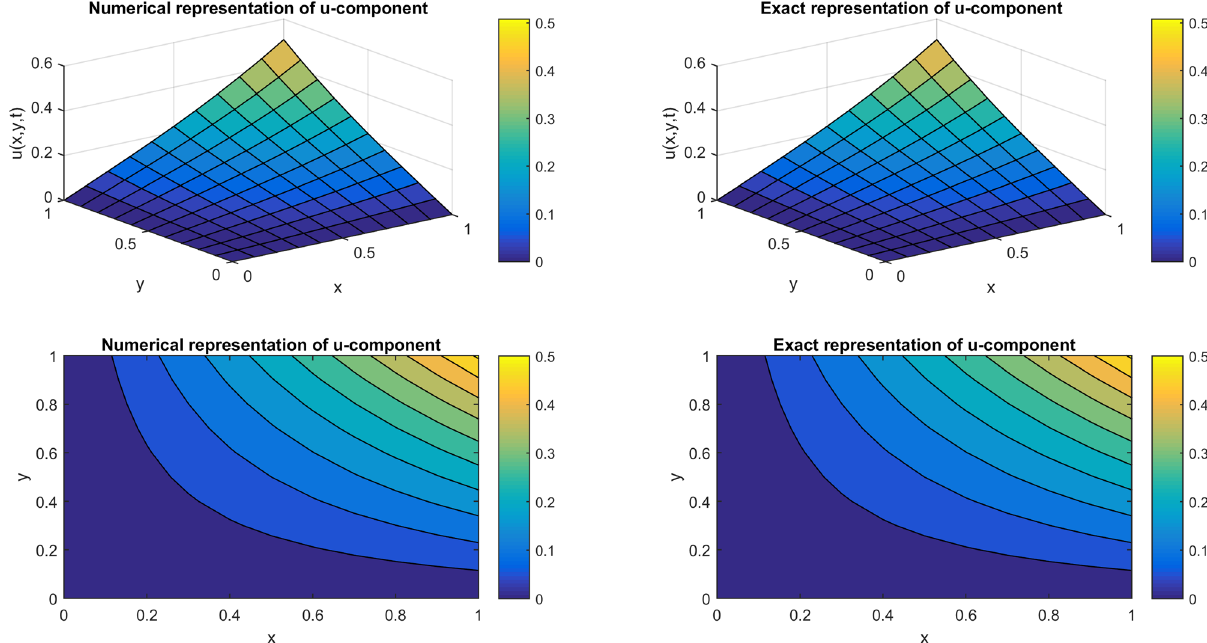
Figure 11: Surface and contour plots for u component at t = 1 for = N 11 , = α 10 , = β 5 , = t Δ 0.0001 , and = τ 0.5 using Method I regarding Example 6.